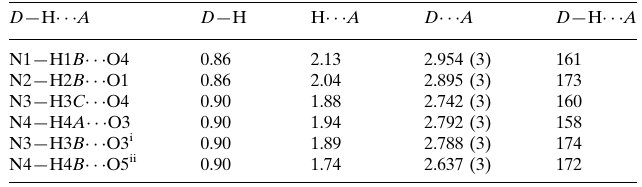
Hydrogen-bond geometry (A˚ , (cid:4)